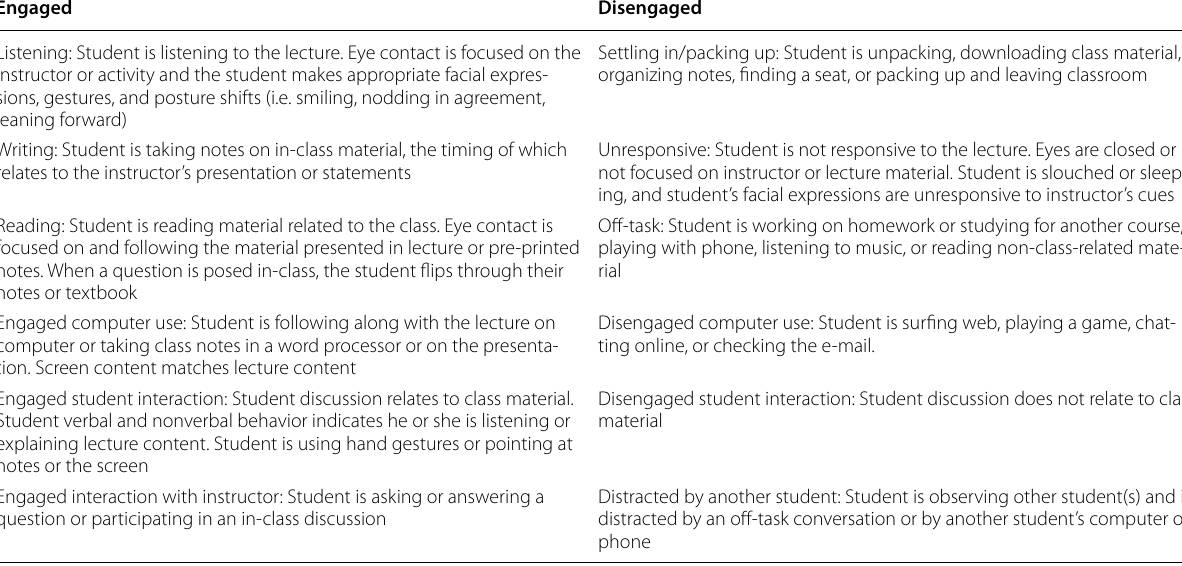
Table 2 Descriptions of students’ in-class behaviors that indicate they are engaged or disengaged. Adapted from: Lane and Harris (2015) Engaged